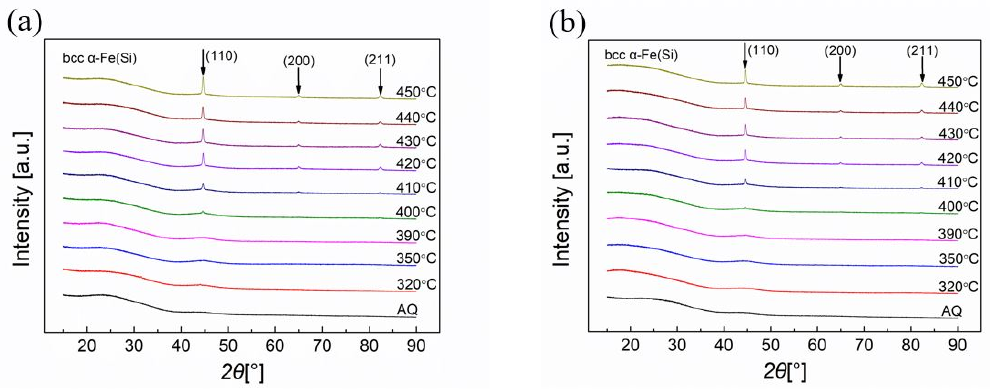
around 6.5 for Metglas 2826MB3. Figure 3. X-ray diffraction (XRD) patterns of Vitrovac ribbons on ( a ) shiny side and ( b ) dull side. The values of k in Metglas ribbons were plotted as a function of H dc , as shown in Figure 4a. Ribbons were annealed under 350 °C to 510 °C with an interval of 10 °C and